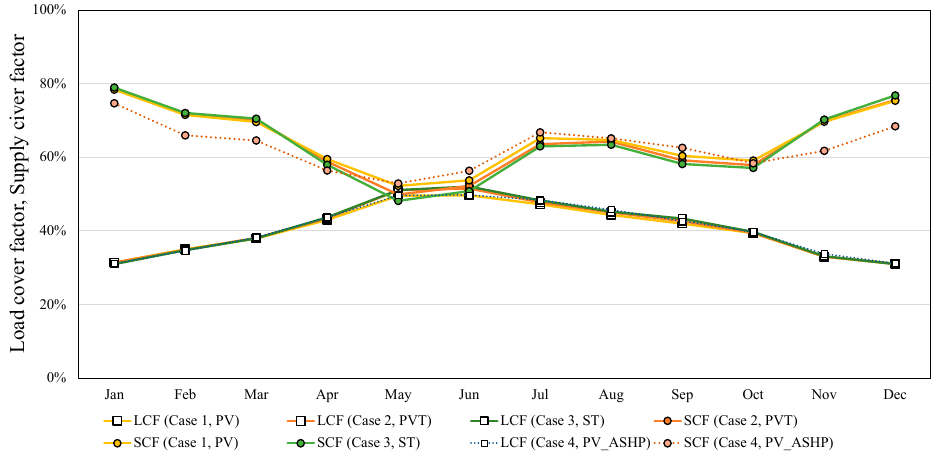
Figure 7. Monthly average LCF and SCF values for different systems.